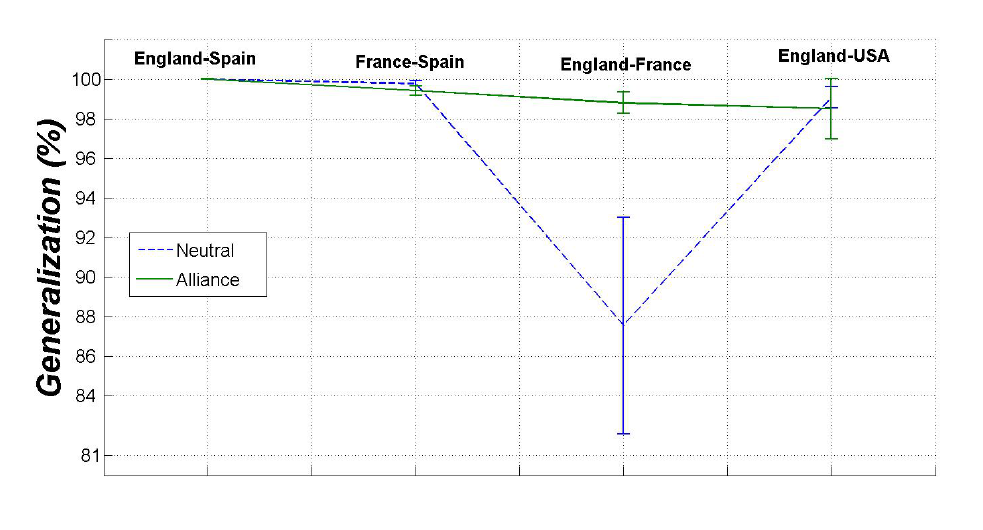
Figure 4. Generalization performance and its standard deviation (the error bars) for the categories Alliance , and Neutral obtained using a ten-fold cross-validation procedure for the time series associated to the link England–Spain . The goal was to check whether the knowledge learned by the predictive model for this link (the deep network with architecture 292 × 239 × 150 × 53 × 19 × 3) might be used to generalize the predictions of the categories associated with the links France–Spain , England–France , and England–USA .